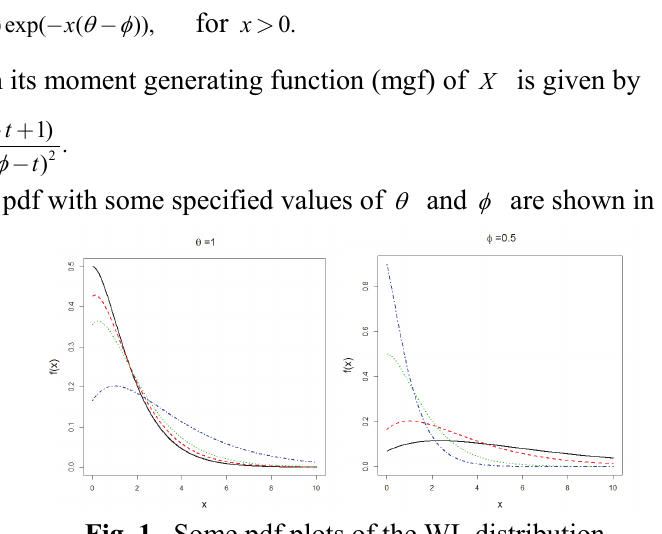
Fig. 1. Some pdf plots of the WL